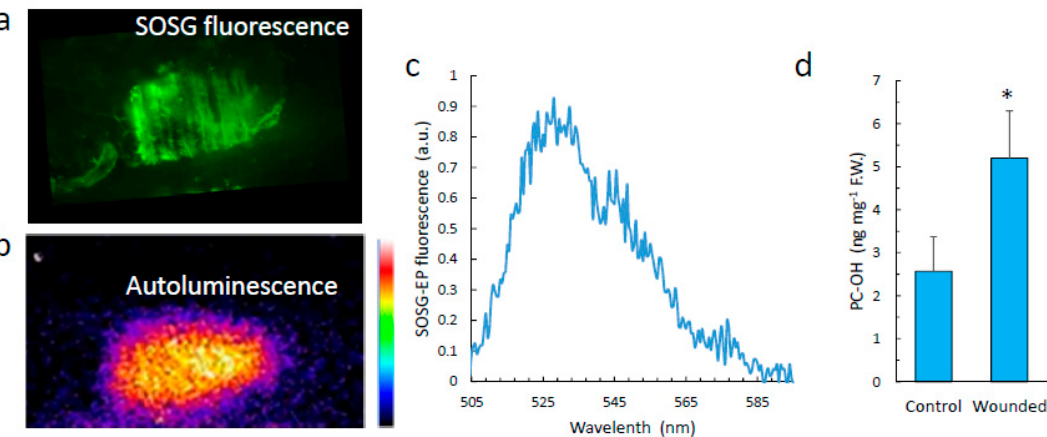
Figure 6. Singlet oxygen in wounded Arabidopsis leaves. ( a ) SOSG-EP fluorescence in a wounded Arabidopsis leaf. ( b ) SCL image of the wound shown in panel ( a ). ( c ) Spectrum of the fluorescence emitted by the wounded leaves pre-infiltrated with SOSG. ( d ) Hydroxy-plastochromanol (PC-OH) levels in control and wounded leaves. *, significantly different from control at p < 0.01 (Student’s t -test).